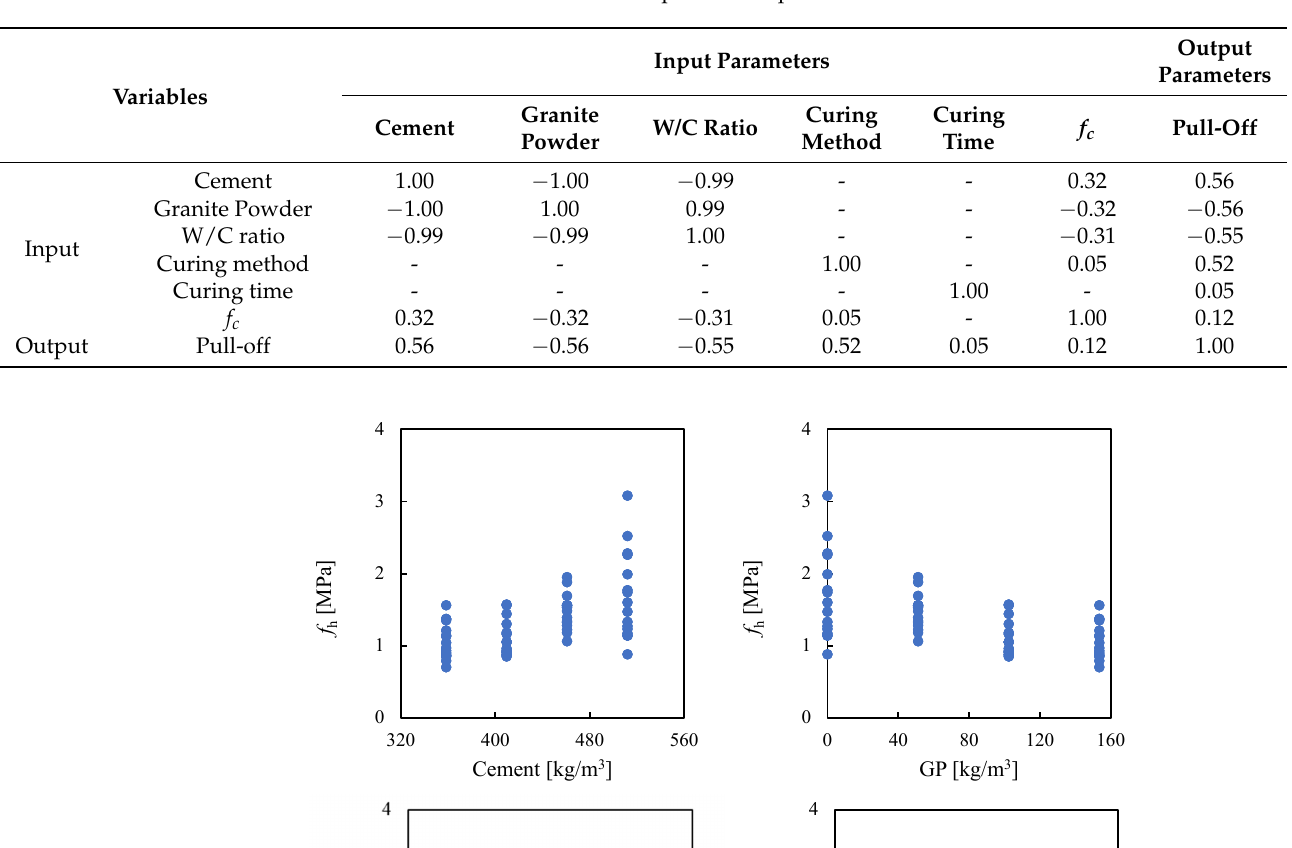
Table 2. Table 2. Range of input and output variables.